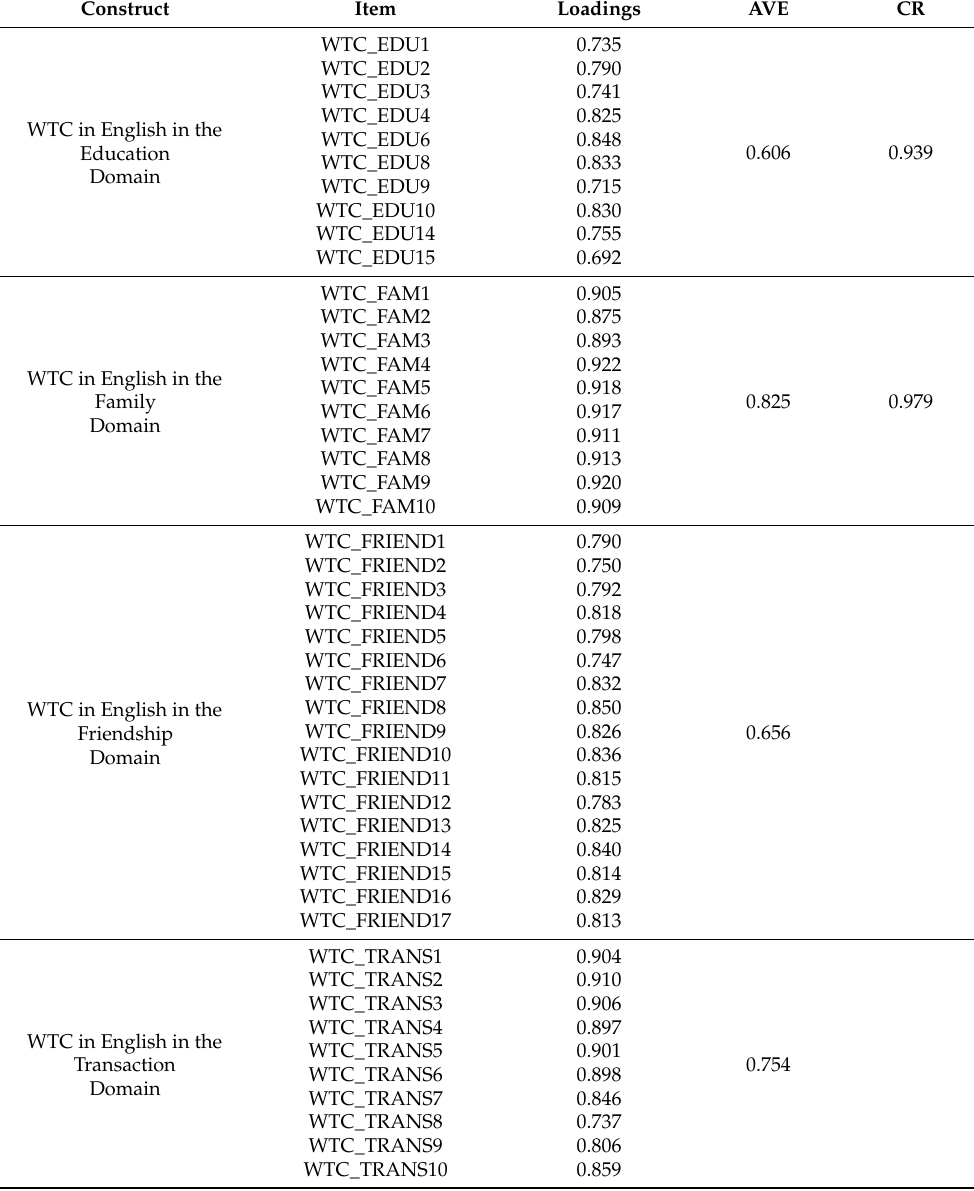
Table 1. WTC in English, reflective measurement